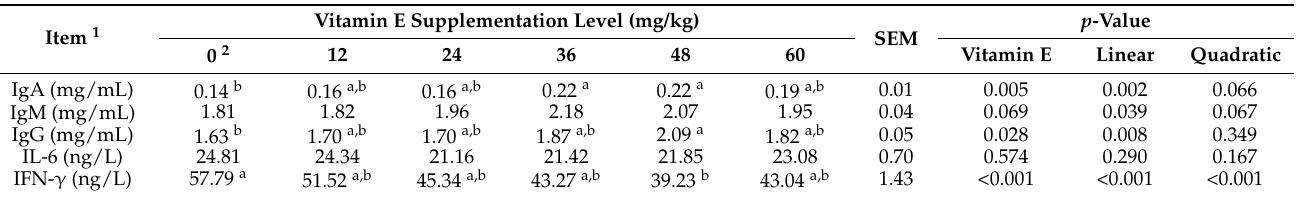
Table 5. Effect of dietary dietary vitamin E supplementation on immunity in the serum of male Jiangnan white goslings on day 28.